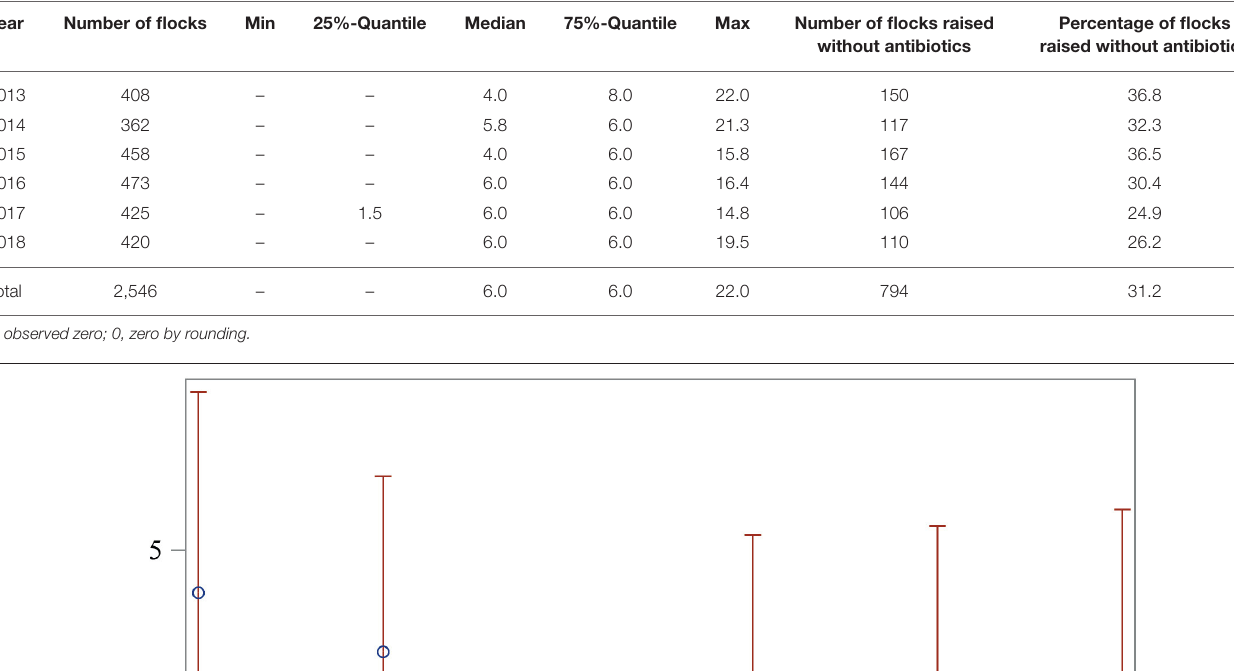
( Table 3 ). The relative TF per antimicrobial class varied over time. The percentage of aminoglycosides and